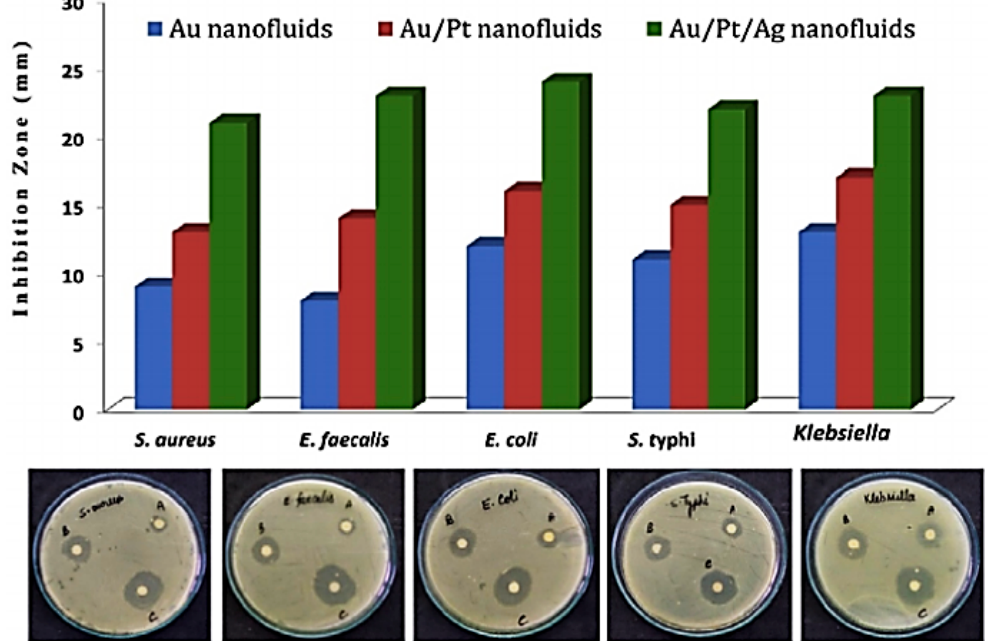
Figure 17. Antibacterial activities of the produced nanomaterials in terms of inhibition zone; Histograms provided comparative zone inhibition of the nanofluids against various bacteria; ‘A’, ‘B’ and ‘C’ in the agar plates correspond to Au, Au / Pt, and Au / Pt / Ag nano-fluid, respectively. Reproduced from [40], with permission from Elsevier, 2018.